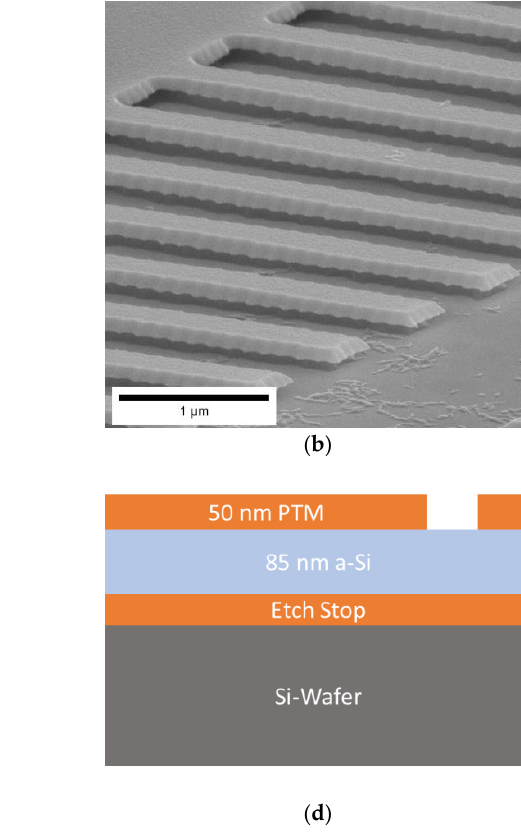
Figure 1. Single layer undercut master. ( a ) SEM image of a FIB-cross-section showing the underetched geometry ( b ) Tilted view SEM image of the single-layer underetched structures. The PTM top layer forms the overhanging ledge on top of the underetched Si base. ( c ) Optical image of wafer is indicating the Blu-Ray mastering of the top PTM layer ( d ) Schematic cross-section through the layer stack.